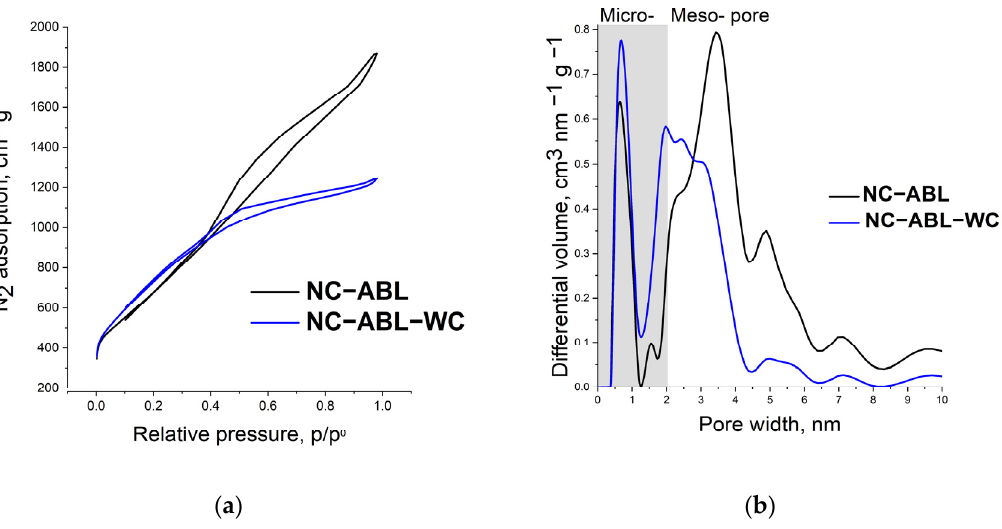
Figure 2. N 2 adsorption–desorption isotherms ( a ) and pore size distribution ( b ) of the NC-ABL and NC-ABL-WC samples. Table 1. The porous structure of NC-ABL and NC-ABL-WC carbon samples.